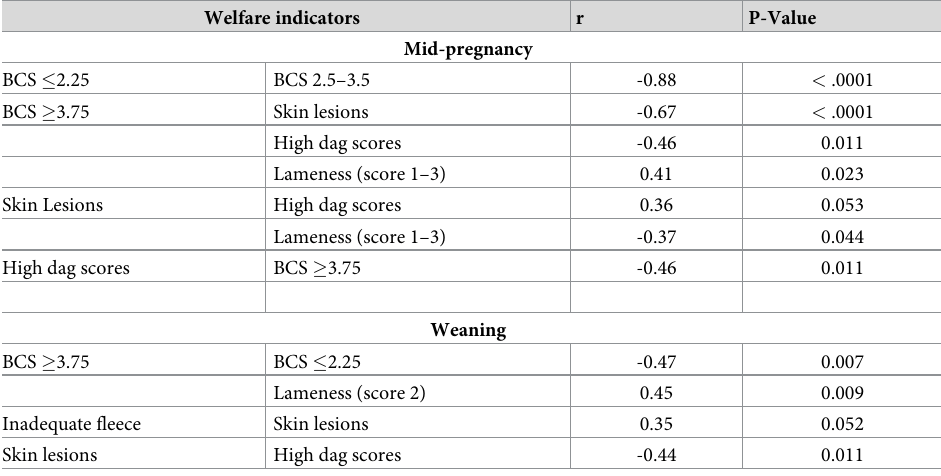
Table 4. Spearman’s Rank correlations between the welfare